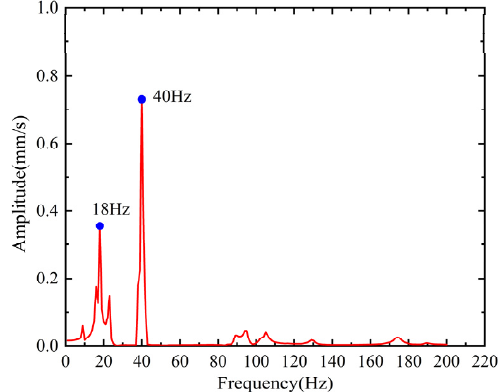
Figure 7. Finite element structure model: A—uniform torque; B—fixed constraints; C—cylindrical constraints; D—rolling force; E—rolling force . Figure 8. Torsional vibration characteristic curve .